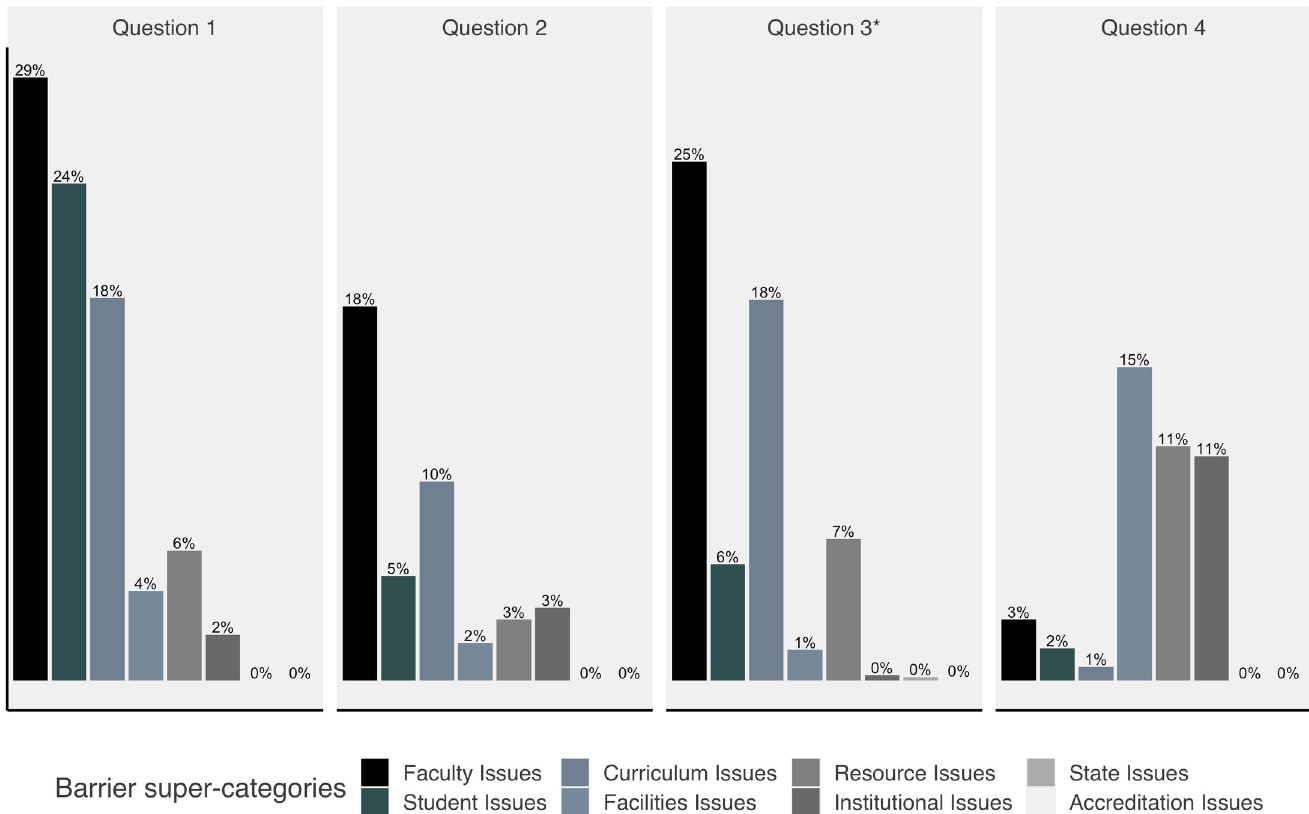
Fig 3. Barriers reported across questions. Faculty-related barriers were consistently the top reported barriers in all questions, except Question 4, which asked specifically about technical barriers. � Question 3 was only shown to respondents who indicated they were not currently integrating bioinformatics into their teaching.